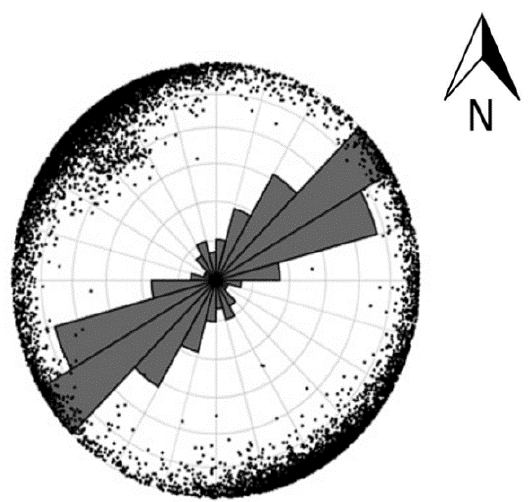
Figure 10. The rose diagram shows fracture dip azimuths (dark points) and fracture strike azimuths (rose petals).